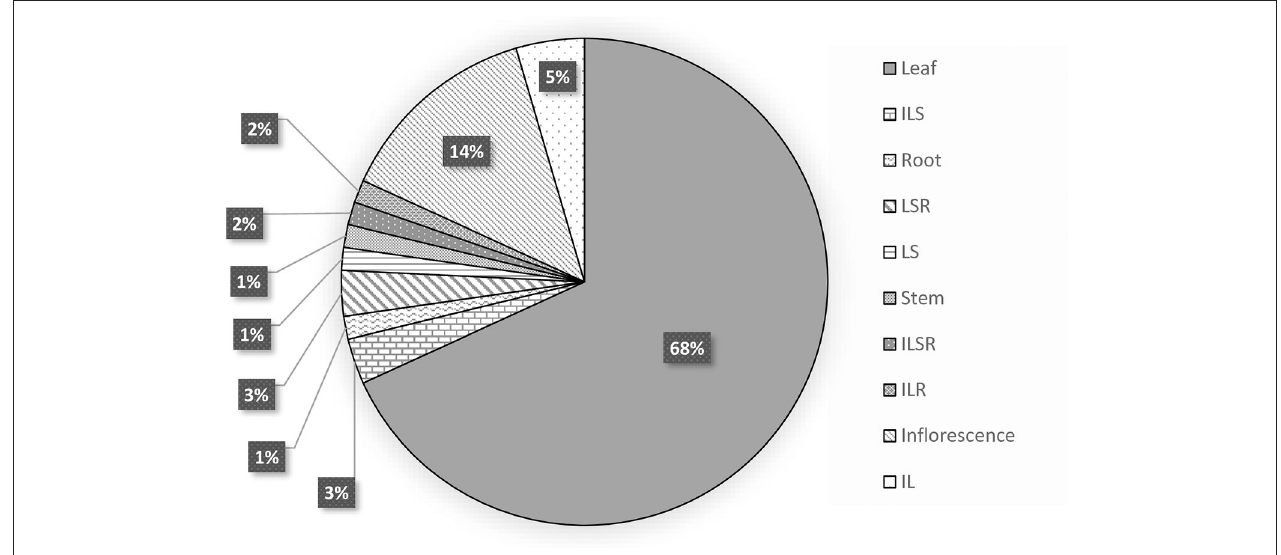
FIGURE 1 | Percentage prevalence of case studies on the parts of plant used to test for insecticidal activities of invasive alien plants. Data was obtained from 69 published case studies. IL, Inflorescence and leaf; ILS, Inflorescence; leaf and stem; ILR, Inflorescence; leaf and root; ILSR, Inflorescence; leaf, stem and root; LS, Leaf and stem; LSR, Leaf, stem, root.